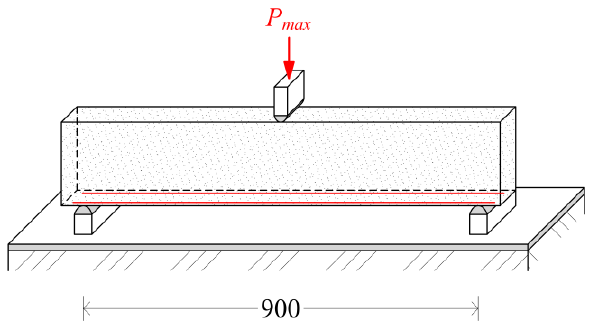
Figure 18. Test scheme of the beam with reinforcement.